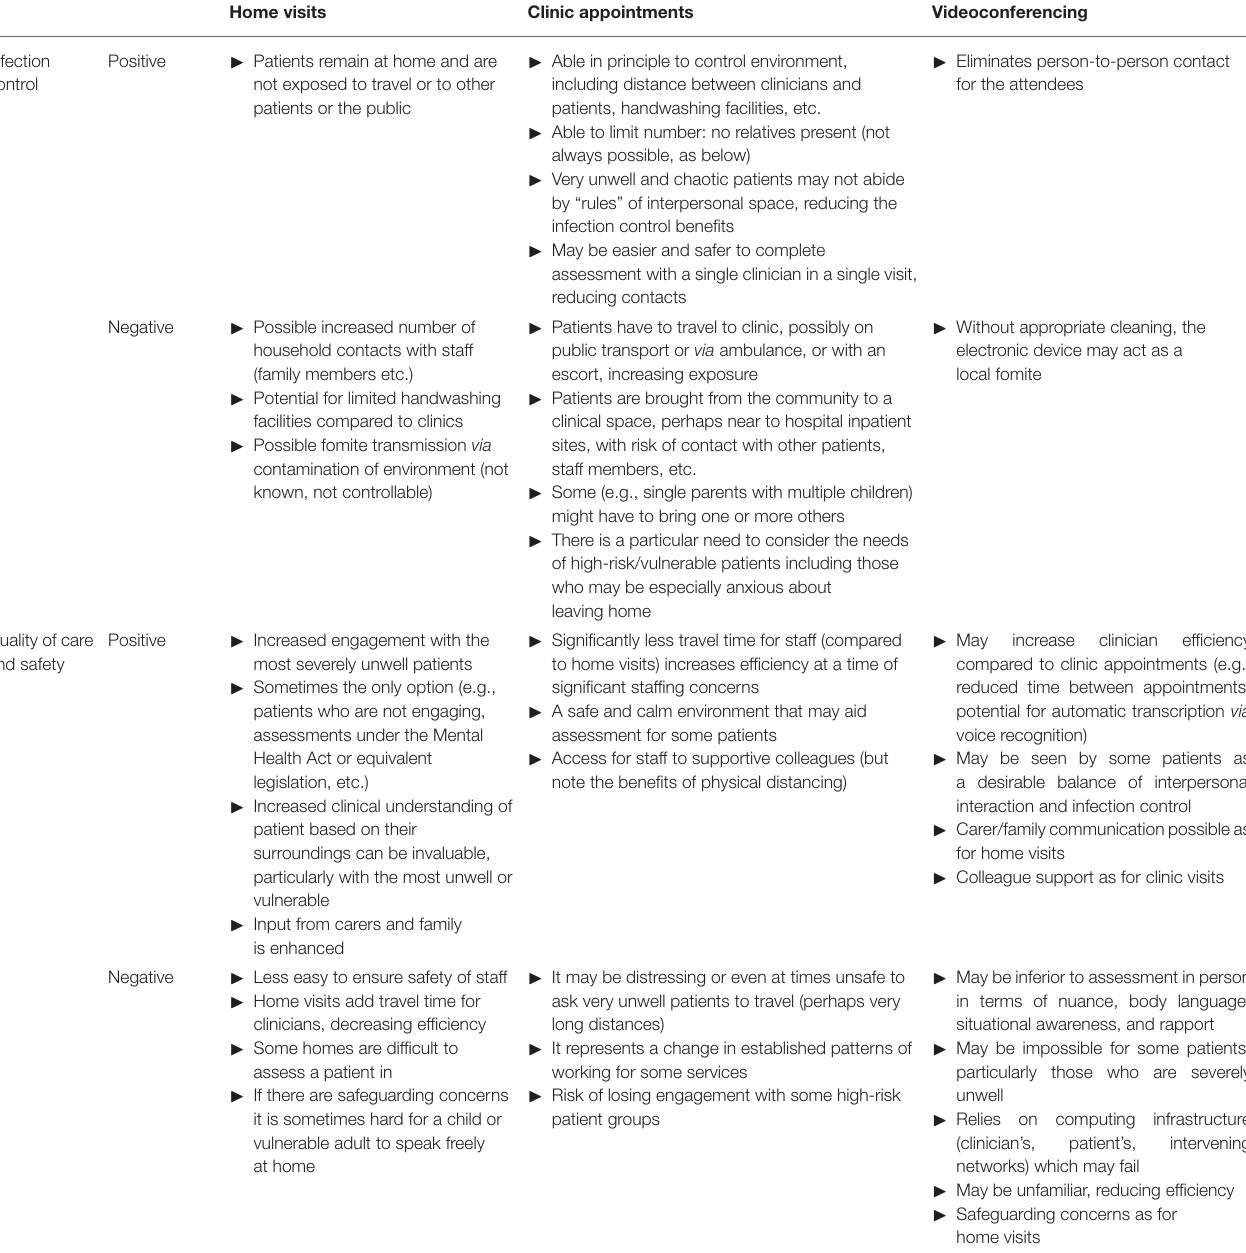
TABLE 1 | Infection control and clinical factors to consider for home visits, clinic appointments, and